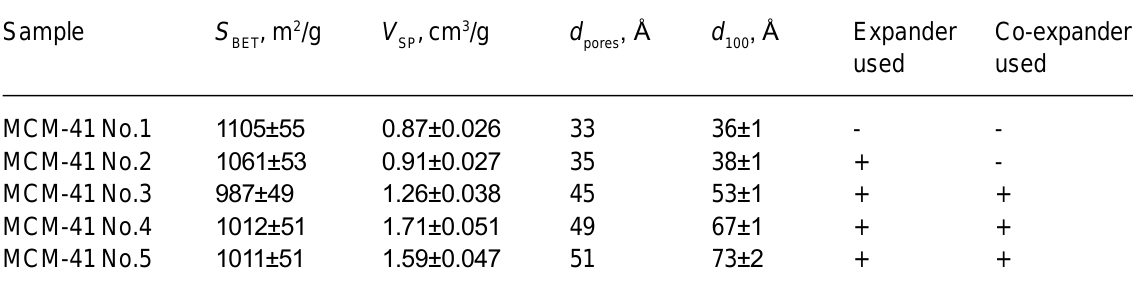
Table 1. Geometrical parameters of silica samples.